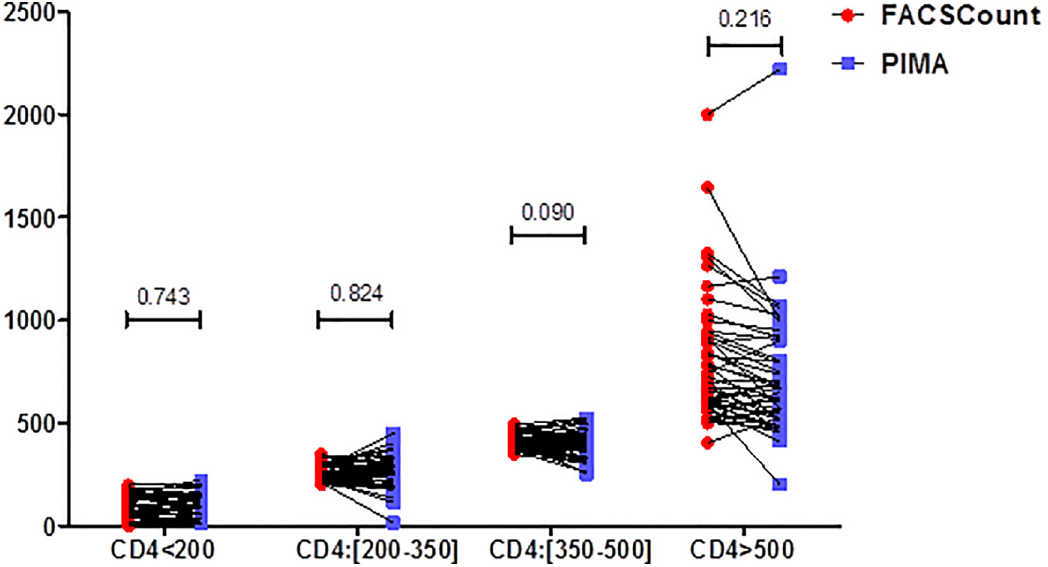
Fig 1. Analysis of the median CD4 counts between the PIMA and the FACSCount. Categories of absolute CD4+ T- cells counts ( < 200/mm 3 , [200-350/mm 3 ], [351-500/mm 3 ], and > 500/mm 3 , in before-after scatter plots comparing the PIMA TM Alere and the BD FACSCount TM are shown. Data are shown as median values. P-values were calculated in SPSS 20 using nonparametric Mann-Whitney U test and the graphing was performed using GraphPad Prism software version